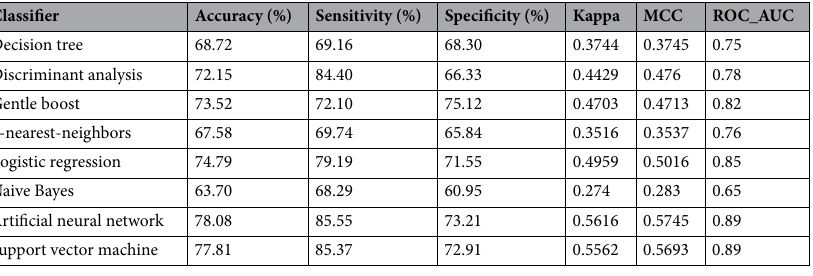
Table 2. Performance results for machine learning algorithms using leave-one-patient-out cross validation method.